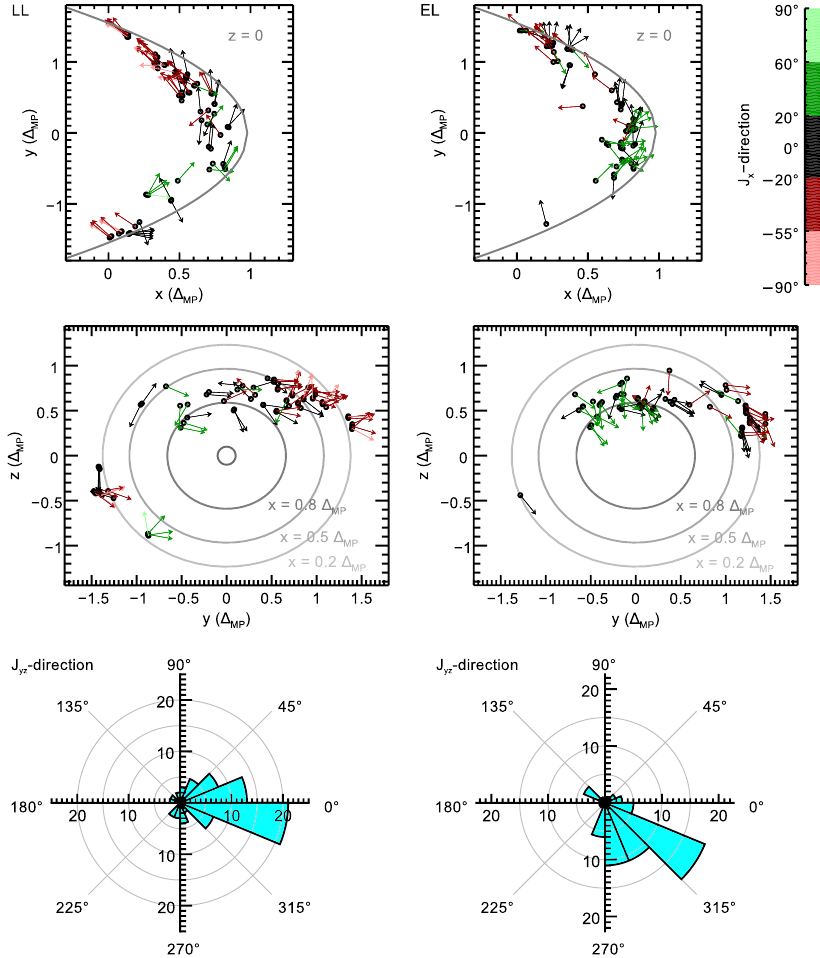
Figure 8. Current directions for LL (left) and EL (right) transitions in GSE coordinates at the reference magnetopause projected into the x – y plane (top panel) and y – z plane (middle panel). The grey paraboloid and ellipsoids represent the magnetopause position at z = 0 and x = 0 . 2 , 0 . 5 , 0 . 8 (cid:49) MP , respectively. The colour code represents the J x direction. The polar histograms show the occurrence rate of the current angle within the y – z plane with respect to the positive y